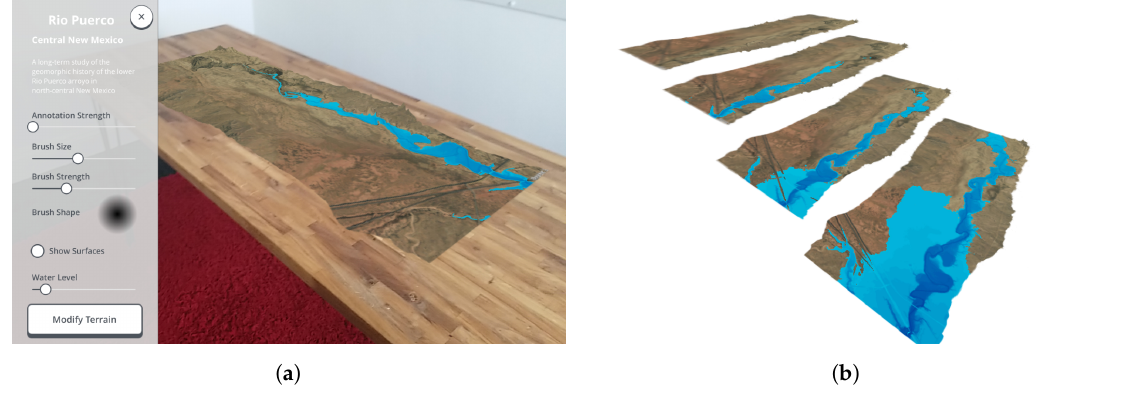
Figure 5. Flood Visualisation ( a ) A screenshot of the flood visualisation software in use ( b ) A visualisation of water level progression using our built-in flood simulator. Underlying DEM data from the 2010 Rio Puerco River Study of overbank flood dynamics